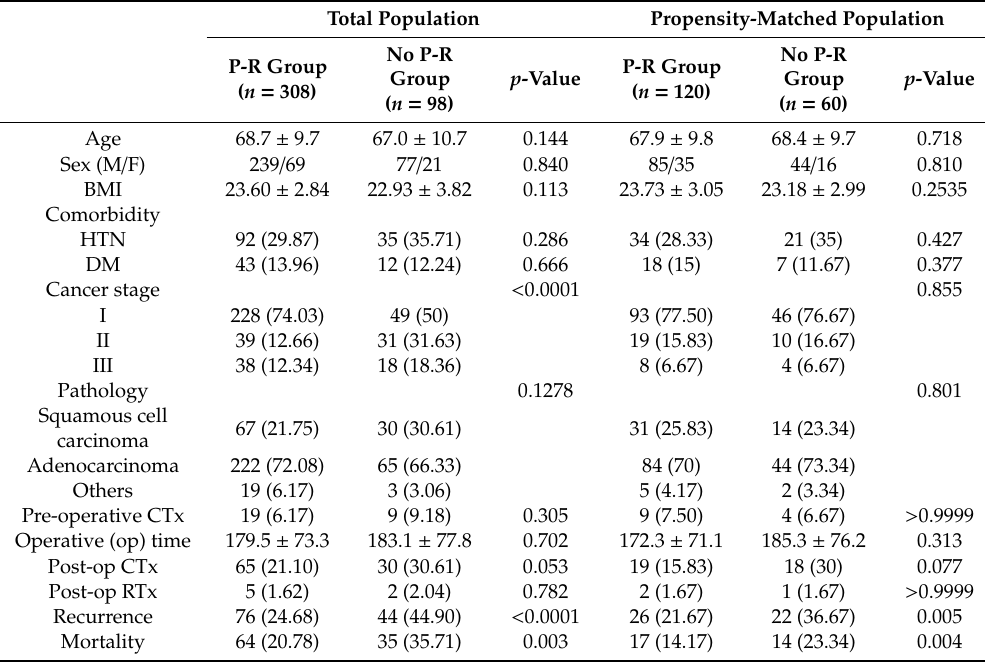
Table 1. Demographic and perioperative characteristics.